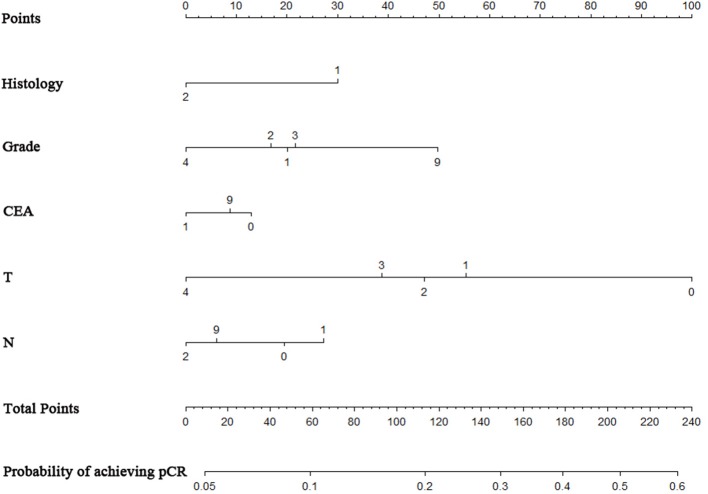
Nomogram to predict the probability of achieving pCR. The factors of grade, histology, CEA, T-classification, and N-classification were included in the model. Histology: “1” = adenocarcinoma, “2” = mucinous adenocarcinoma; grade: “1” = well, “2” = moderate, ”3” = poor, “4” = undifferentiated; T stage classification: “1” = T1, “2” = T2, “3” = T3, “4” = T4. N stage classification: “1” = N1, “2” = N2.